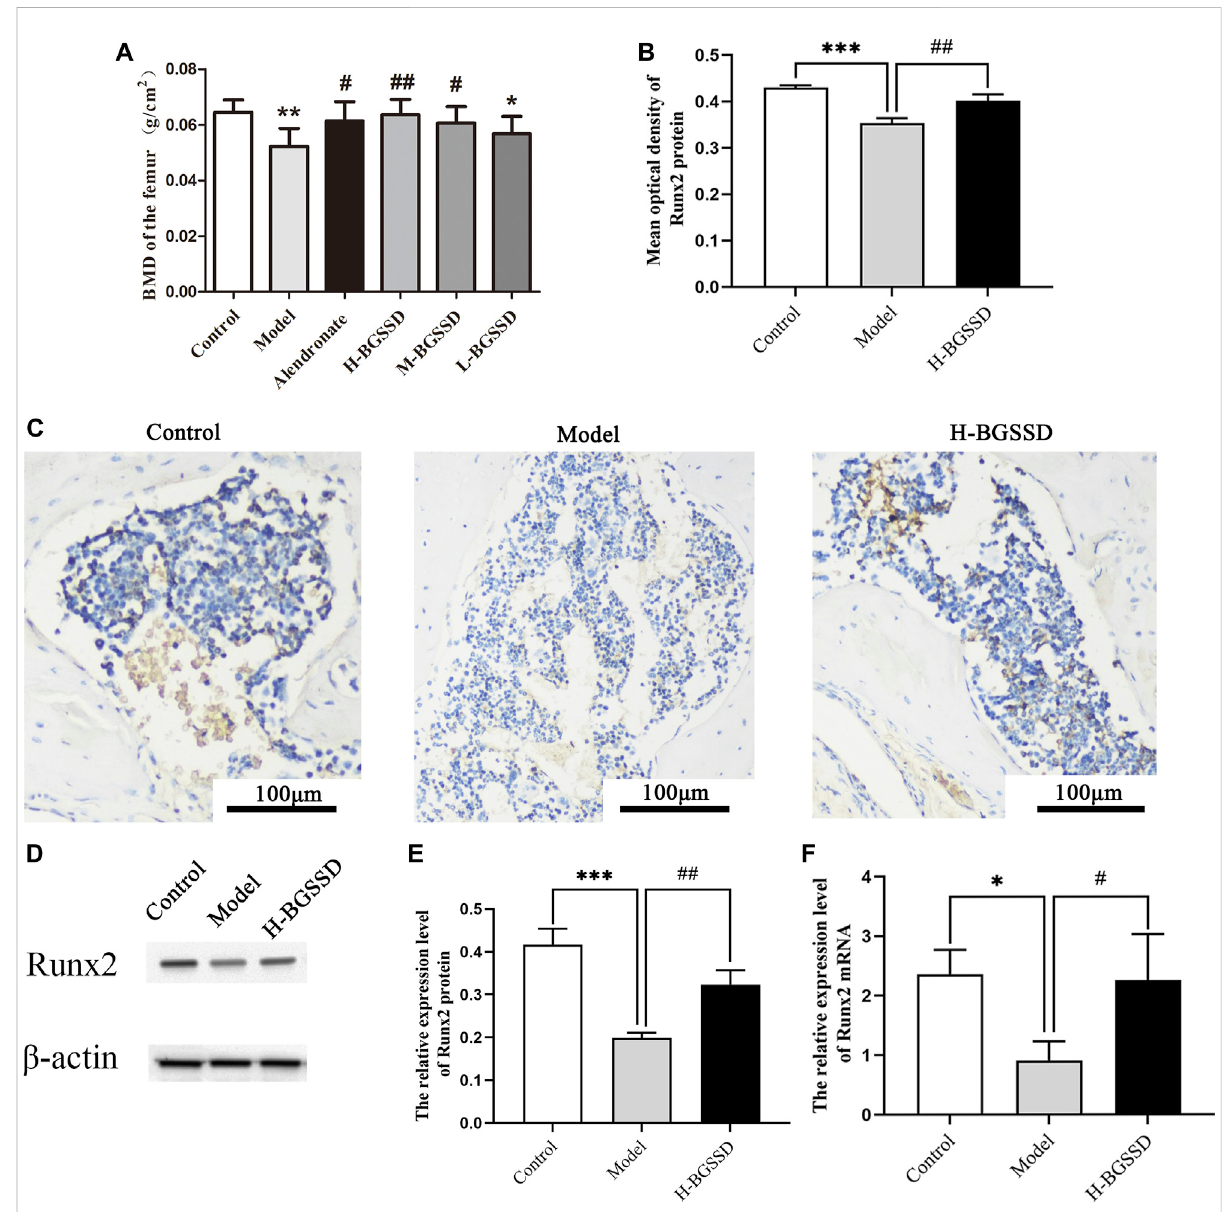
FIGURE 1 BGSSD promoted bone formation of SAMP6. Control: control group (SAMR1), Model: model group (SAMP6), H-BGSSD: High-dose BGSSD- treated group, M-BGSSD: middle-dose BGSSD-treated group, L-BGSSD: low-dose BGSSD-treated group, Alendronate: positive control, alendronate-treatedgroup.First,BGSSDraisedtheBMDofthefemoralinSAMP6. (A) X-rayimagingwasperformedonthefemurscollectedfromthe above groups. BMD of each group was measured by dual-energy X-ray absorptiometry. Data are expressed as mean ± SD, * p < 0.05, ** p < 0.01 compared with the control group; # p < 0.05, ## p < 0.01 versus the model group. Furthermore, BGSSD promoted overexpression of osteogenic speci fi cfactorRunx2 inSAMP6 . (C) Immunohistochemicalstaining was carried out to evaluate theexpression of Runx2protein inbone tissue. Scale bar=100 µm. (B) ThemeanopticaldensityofRunx2proteinwasquanti fi edbyImageJ.Valueswereexpressedasmean±SD,*** p < 0.001themodel group versus the control group; ## p < 0.01, the group of H-BGSSD versus the model group. WB was carried out to assess the expression of Runx2 protein in bone tissue. (D) Representative images of WB. (E) The quanti fi cation of the protein expression level of Runx2, samples were collected fromthe bone tissue. Values were expressed as mean ± SD, *** p < 0.001, versusthe control group; ## p < 0.01, versusthe model group. (F) The mRNA expression of Runx2 in bone tissue was assessed by RT-PCR. Values were expressed as mean ± SD, * p < 0.05, versus the control group; # p < 0.05, versus the model group. All the assays were repeated more than three